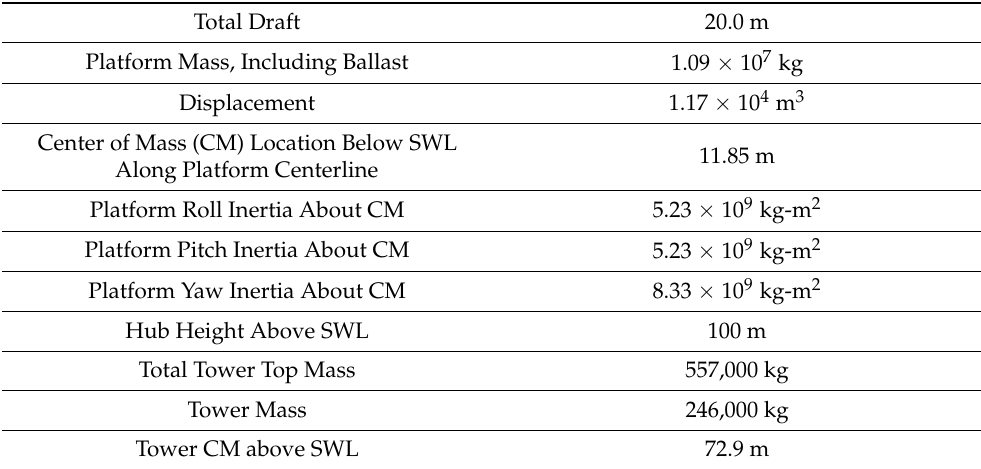
Table 3. FOWT Component Mass and Locations .